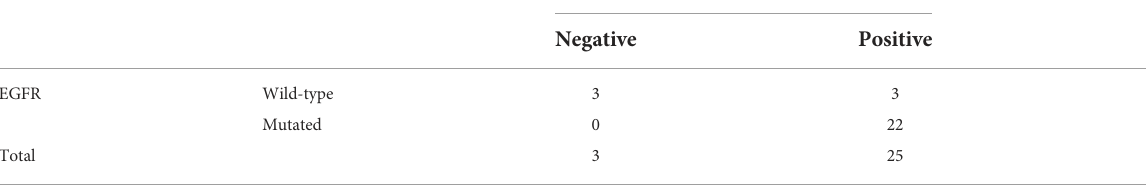
EGFR Wild-type 3 3 6 Mutated 0 22 22 Total 3 25